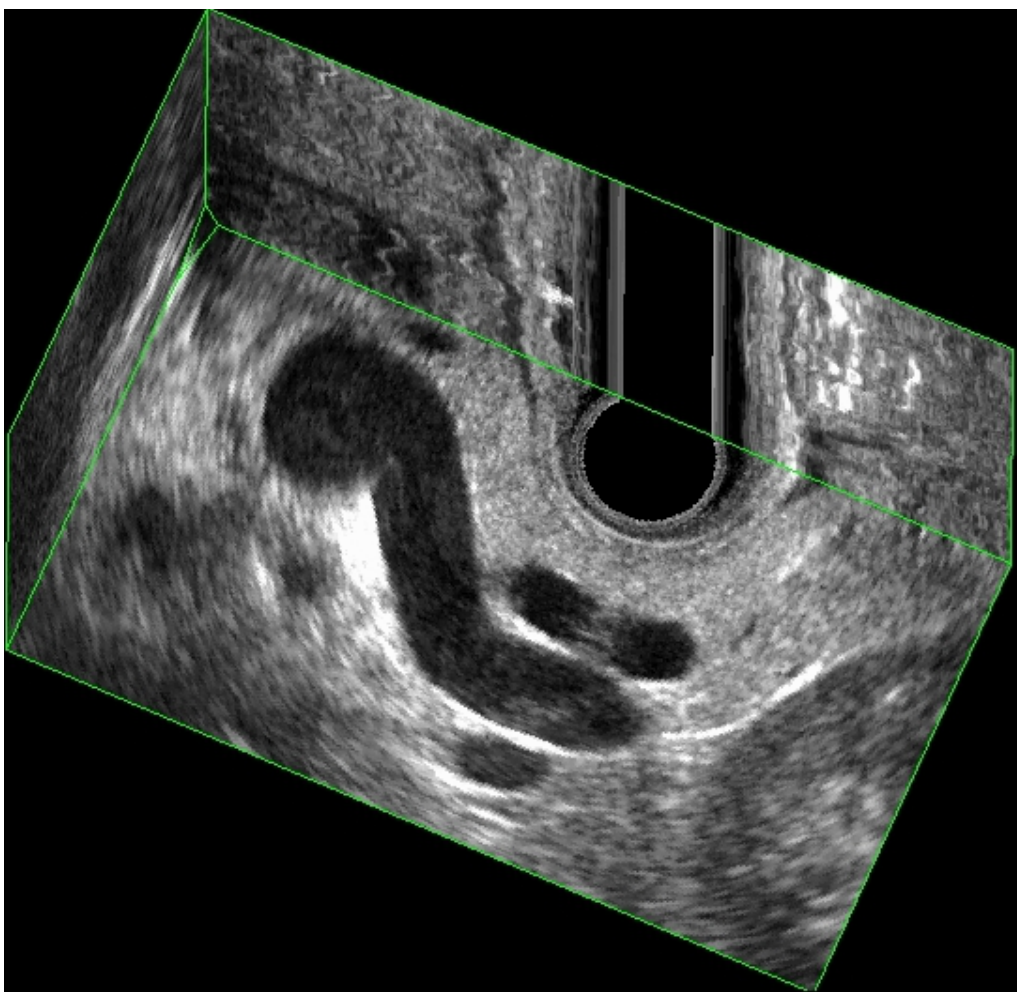
FIGURE 1 . Normal 3-D reconstruction of normal pancreas using an electronic radial probe (Pentax-EG 3670UKR).